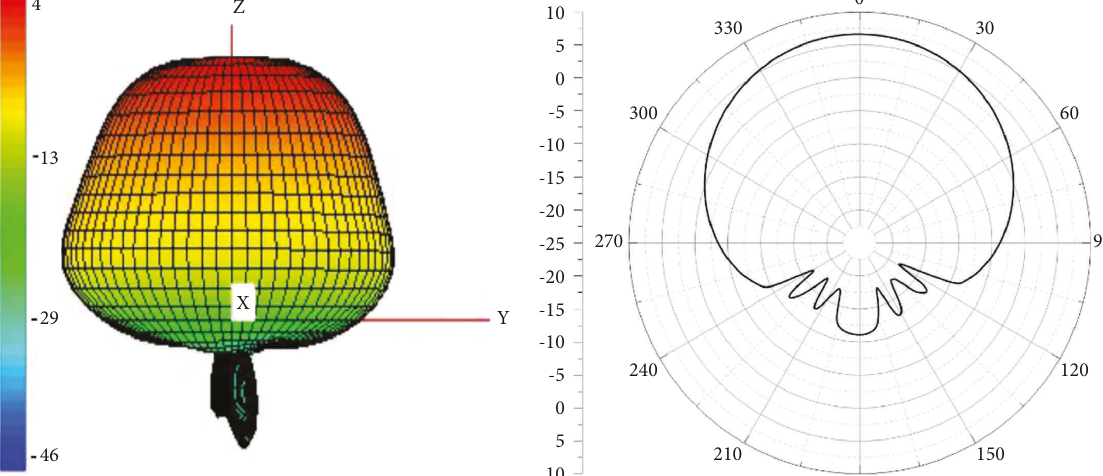
Figure 9: The pattern when the choke is used (simulated and measured